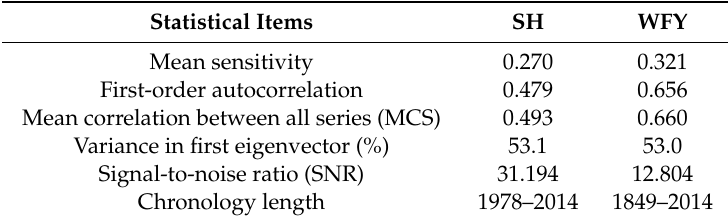
Figure 3. Tree-ring width standard chronologies of ( a ) SH and ( b ) WFY and sample depth. Table 1. Statistical characteristics of the SH and WFY chronologies .